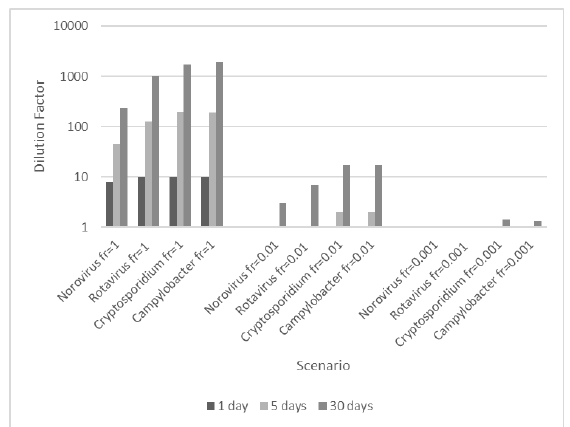
Figure 2. Target dilution factor for intrusion of non-potable reclaimed wastewater (generated by 1000-person collection and treated for indoor reuse) to potable water that results in 95th percentile annual risk of infection from non-potable domestic, indoor reuse equivalent to the benchmark (10 − 4 ppy). The intrusion event duration was either 1, 5, or 30 days for various fractions of the population exposed to the intrusion event (fr). The dilution factor is expressed as 1-part intrusion water: X parts total